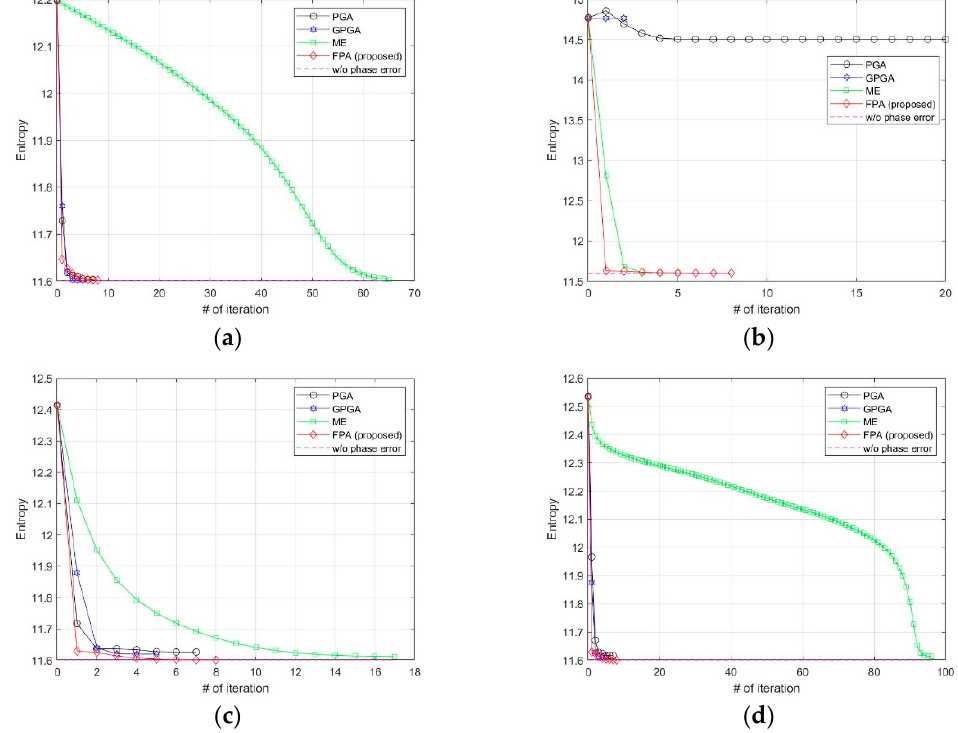
Figure 9. Entropy variations at each iteration for ( a ) quadratic error, ( b ) uniformly distributed random error, ( c ) Wiener process error, ( d ) sinusoidal error with discontinuity.